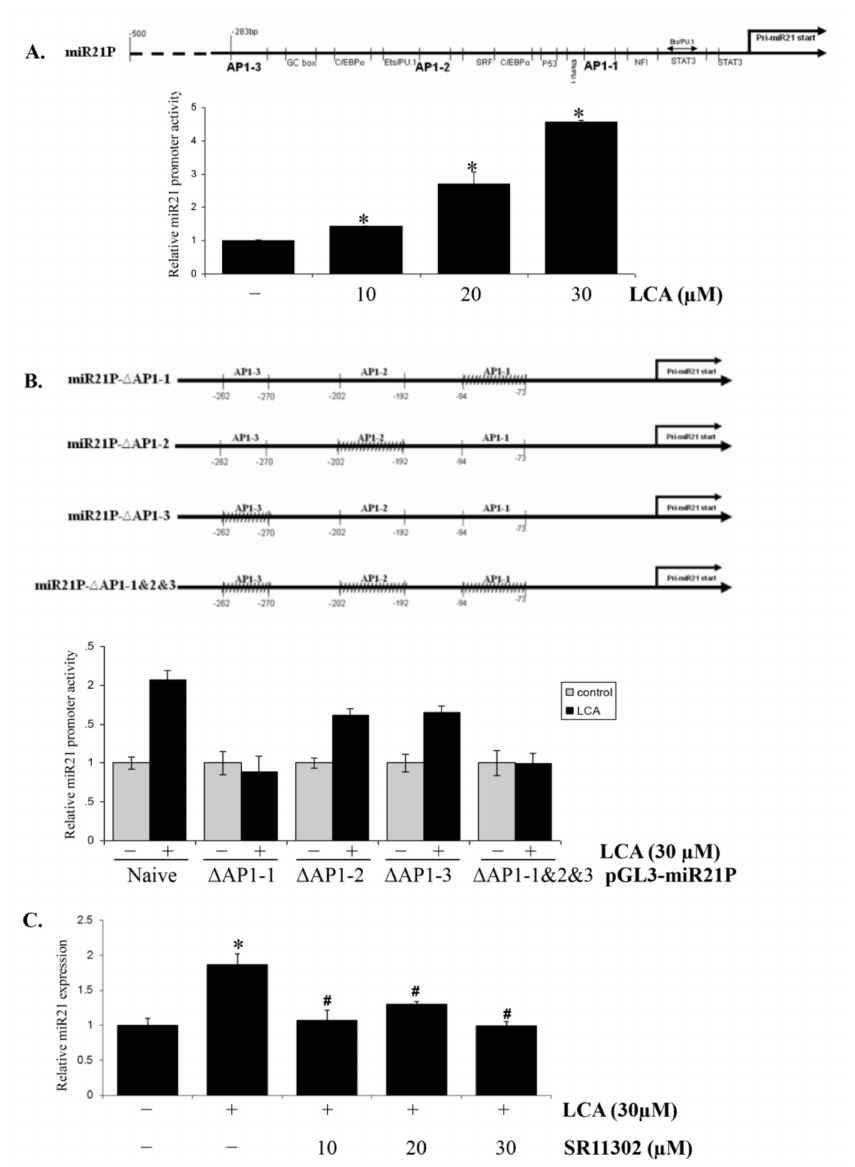
Figure 2. The involvement of AP-1 transcription factor in LCA-induced miR21 promoter activity. ( A ) HCT116 cells were transiently transfected with pGL3-miR21 promoter and then treated with 10 µ M–30 µ M LCA for 18 h. The cells were then lysed and checked for miR21 promoter activity by luciferase assay. ( B ) HCT116 cells were transiently transfected with pGL3-miR21 promoter and its mutants at AP-1 binding sites including ∆ AP1-1, ∆ AP1-2, ∆ AP1-3, ∆ AP1-1&2&3. The cells were then treated with 30 µ M LCA for 18 h and submitted to dual-luciferase assay for checking miR21 promoter activity. ( C ) HCT116 cells were treated with AP-1 specific inhibitor, SR 11,302 1 h prior to 30 µ M LCA treatment for 24 h. The cells were then extracted for total RNA and checked for miR21 expression by Realtime-PCR. * p < 0.05 versus control; # p < 0.05 versus LCA. The above data represent the means ± SD from triplicate